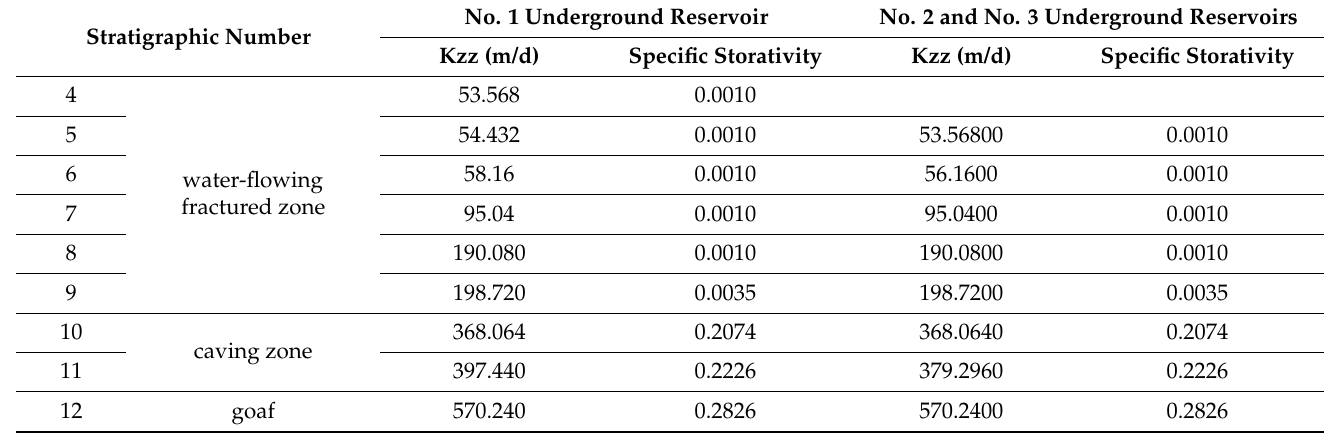
Table 3. The hydraulic conductivity of the actual groundwater reservoir and the upper water-flowing fractured zone in the mining